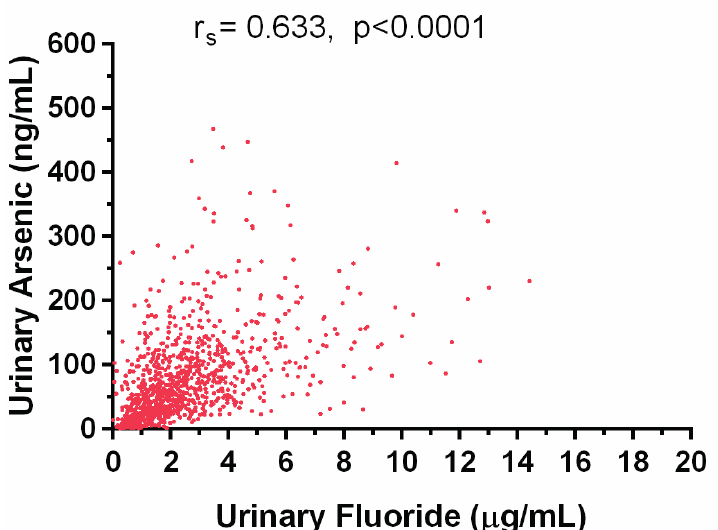
Figure 5. The association between urinary arsenic and fluoride concentrations adjusted for specific gravity. Spearman correlation coefficient and p value are shown for 1119 samples.